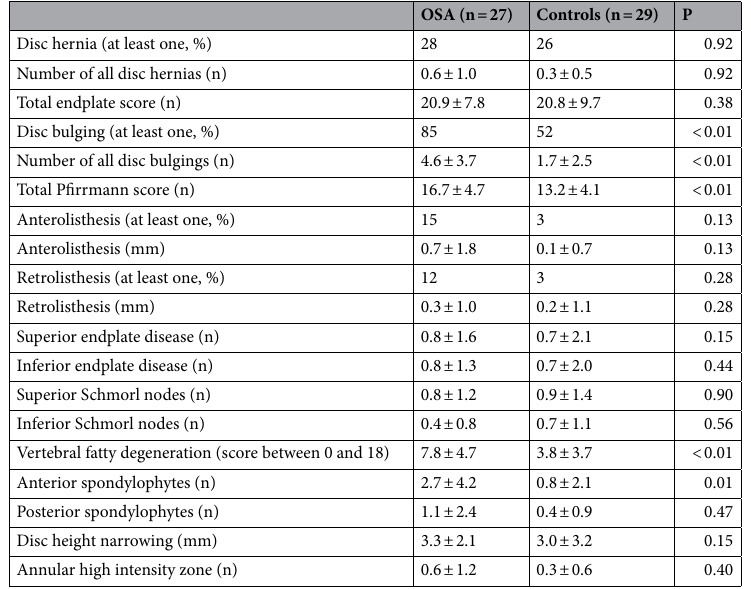
Table 2. Characteristics of lumbar spine spondylosis and discopathy in patients with OSA and controls. Analyses were adjusted for age, gender, BMI, smoking and cardiovascular disease. Data are presented as mean ± standard deviation.